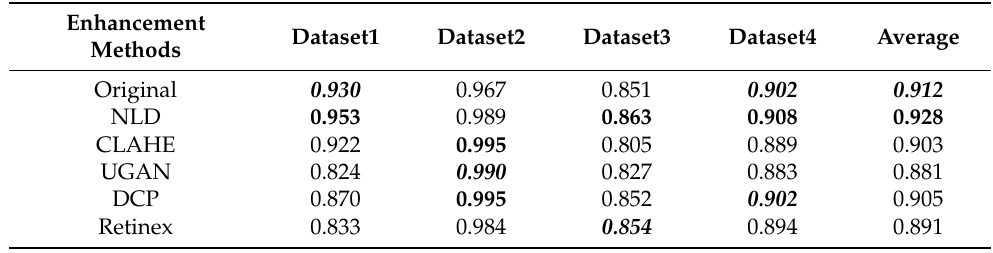
Table 3. Average precision (AP 50 ) of sea cucumber detection at multiple scenes by YOLOv5 (Bold font indicates the best result and italic indicates the second-best result).